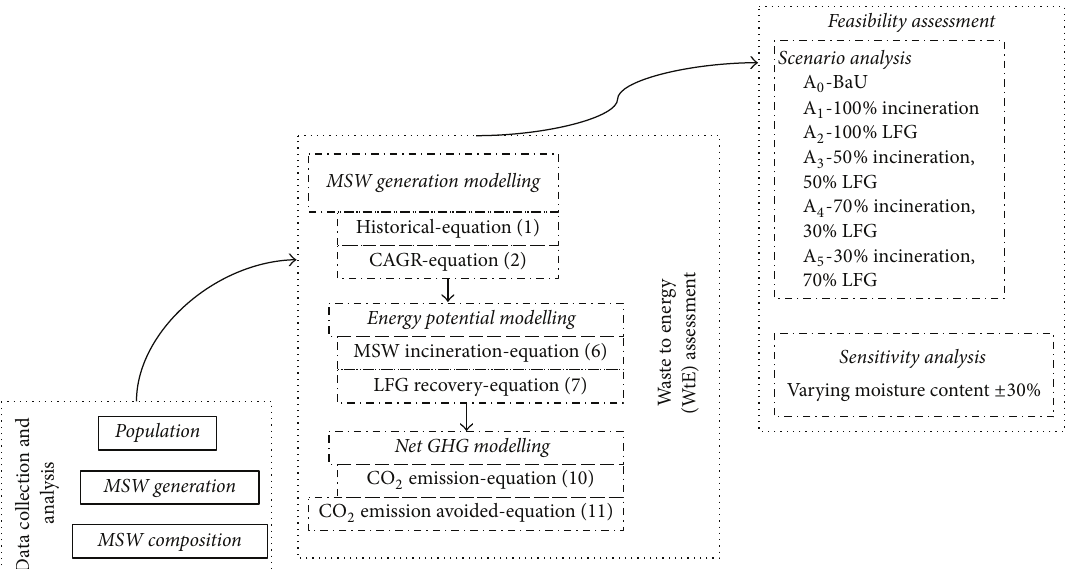
Figure 4: Methodological approach of the